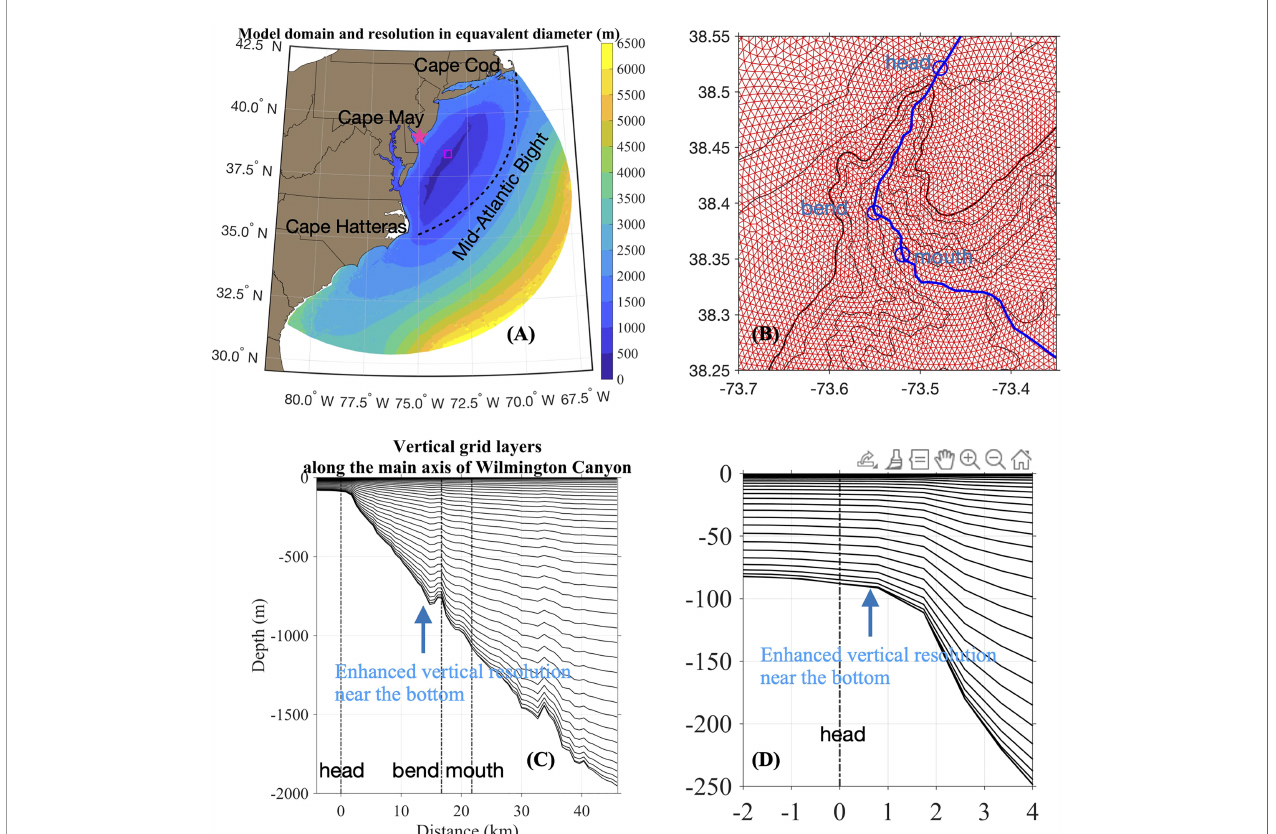
FIGURE 2 | (A) SCHISM model domain and horizontal resolution in equivalent diameter. The model uses >24,000 horizontal nodes, >48,000 unstructured triangular grids, with 350-1000 m resolution over the submarine canyons and adjacent shelf and slope. Location of Wilmington Canyon is indicated by the magenta box. (B) Model mesh over the Wilmington Canyon. Blue line indicates a transect along the canyon ’ s main axis. Visualization of model vertical layers (C) along the axis of Wilmington Canyon, and (D) zoomed in near the canyon head. There are up to 55 vertical layers depending on water depth. Relatively high vertical resolution is set up for near the surface and bottom. The thickness of the bottom model layer is generally 0.1-5 m over the shelf, shelf-break, and